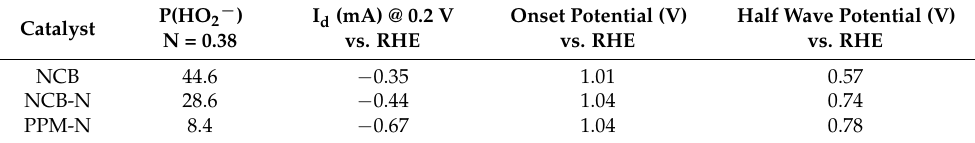
Figure 2. Voltammograms on NCB, NCB-N, and PPM-N of oxygen reduction reaction with rotating ring-disk electrode in 1.0 M KOH at room temperature. Table 2. Electrochemical performance of NCB, NCB-N, and PPM-N using RRDE.